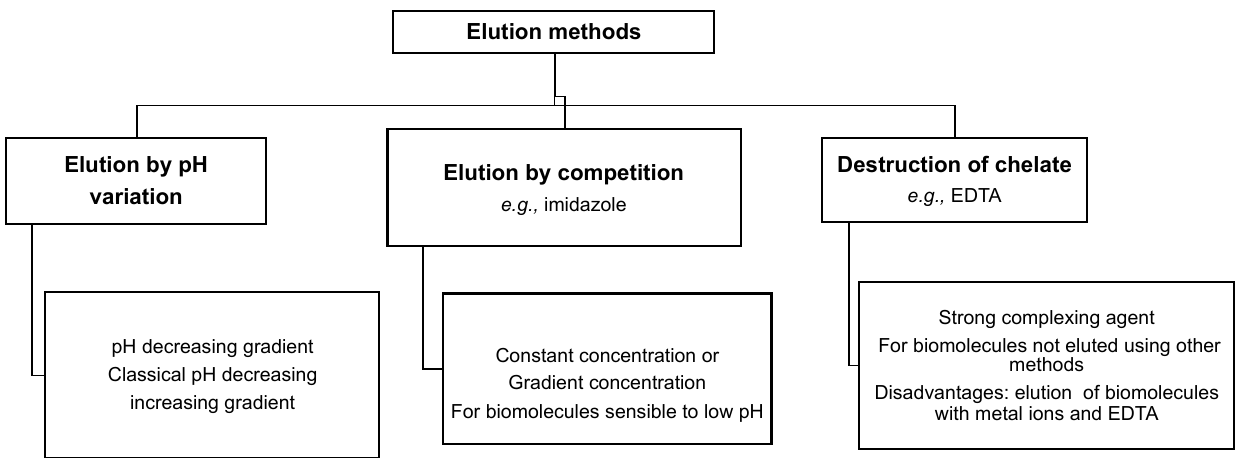
Figure 4. The elution methods commonly used in immobilized metal ion affinity chromatography.